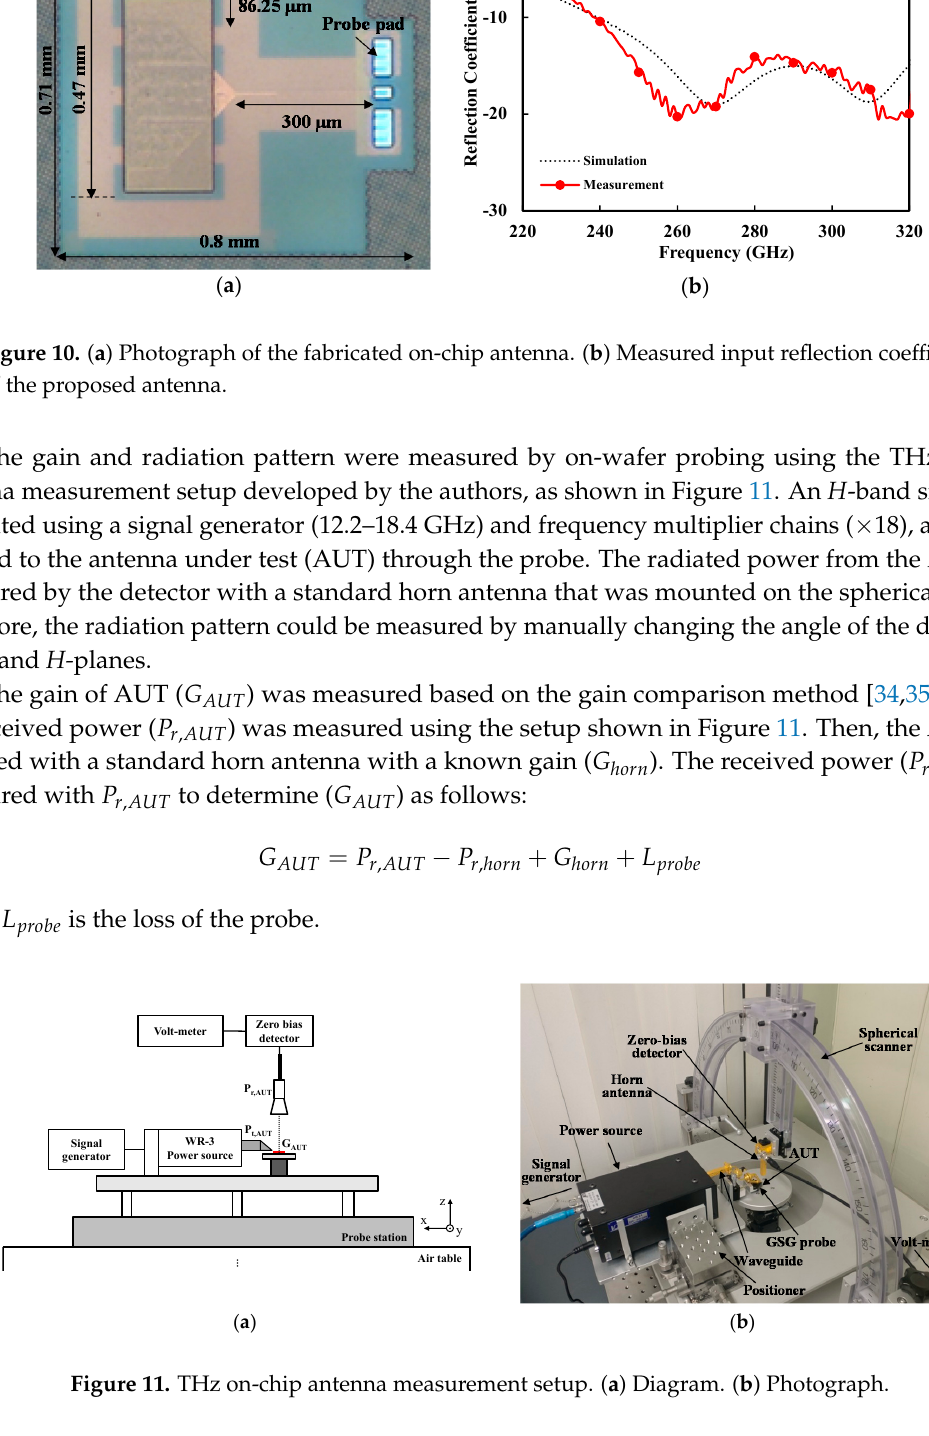
Figure 10. ( a ) Photograph of the fabricated on-chip antenna. ( b ) Measured input reflection coefficient of the proposed antenna.